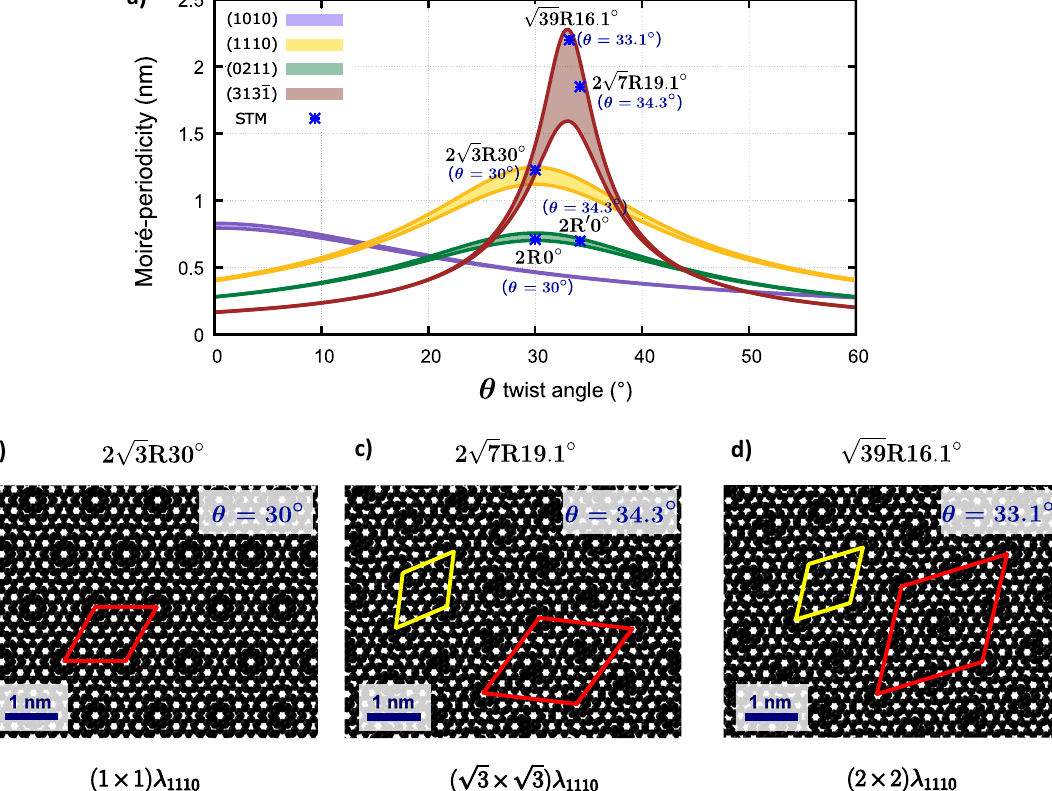
Fig. 5 Analysis of the Moiré-wavelength and the identi fi ed MoTe 2 /graphene commensurate superstructures near twist angle θ of 30 ∘ between the hexagonal lattices. a Calculated wavelength of differently indexed Moiré patterns in the twist angle range of θ = 0 ∘ − 60 ∘ with MoTe 2 lattice parameters 3.56 Å (lower curves) and 3.49 Å (upper curves). Blue stars represent the STM measured Moiré periods with the corresponding Wood's notations and twist angle values ( θ ) of the structures. b – d Model MoTe 2 and graphene lattices rotated above each other. Red rhombuses correspond to commensurate supercells of the Moiré domains experimentally identi fi ed in Figs. 2 – 4, yellow rhombuses correspond the λ 1110 Moiré pattern. The relationship between the supercells (red rhombus) and the λ 1110 pattern are the following: (1 × 1) λ 1110 ffiffiffi p ffiffiffi p ffiffiffi p ffiffiffi p ffiffiffiffiffi p ´ Þ λ 3 3 3 7 39 for 2 R30 ∘ , ð R19.1 ∘ , and (2 × 2) λ 1110 for R16.1 ∘ 1110 for 2